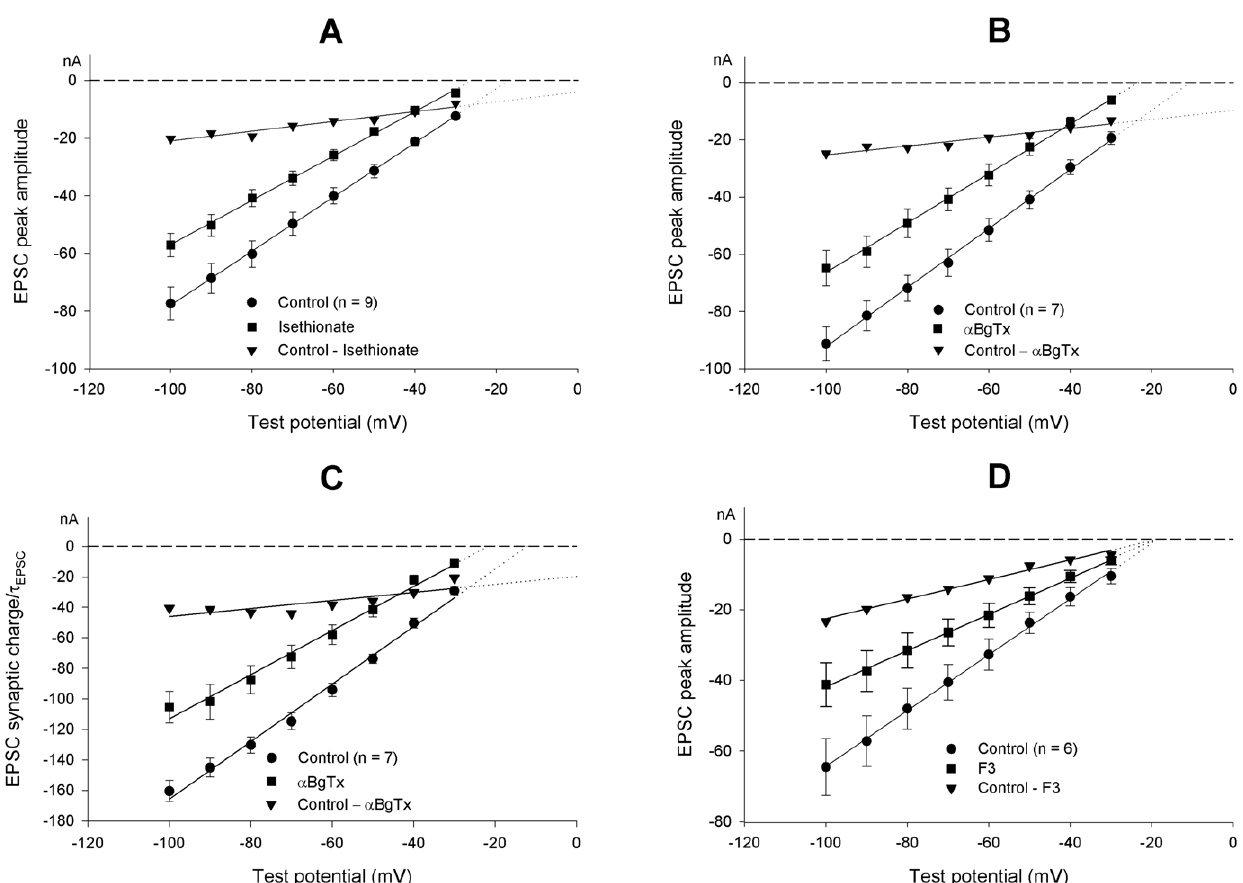
Figure 2. Effect of [Cl 2 ] o modifications and of pharmacological treatments on EPSC I–V curves. ( A ). Mean I–V relationship of EPSCs evoked before (circles) and after substitution of 136 mM isethionate for an isoosmotic amount of NaCl (squares). Analysis indicates a shift of the P K / P Na ratio from 1.57 6 0.09 to 2.26 6 0.08 in low chloride solution. Peak amplitude difference values (triangles) are used to build the I–V curve of the current cancelled by the treatment: note its largely positive equilibrium potential. ( B ). Effect of 200 nM a BgTx application. The I–V curves of the EPSC peak amplitude before (circles) and after toxin treatment (squares) are shown. The difference current relationship (triangles) was drawn as in ( A ). ( C ). The ratio EPSC-charge/EPSC-decay time constant is fitted against test potential (same data as in B ). ( D ). Effect of the selective nicotinic antagonist F3 (10 m M; squares) vs. controls (circles); triangles show the corresponding difference plot of the EPSC amplitudes.